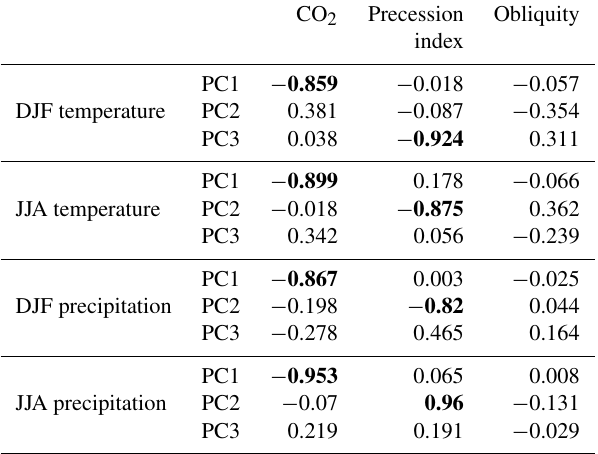
Table 6. R correlation values for forcing factors and PC scores. Values where R 2 ≥ 0.5 are shown in bold.